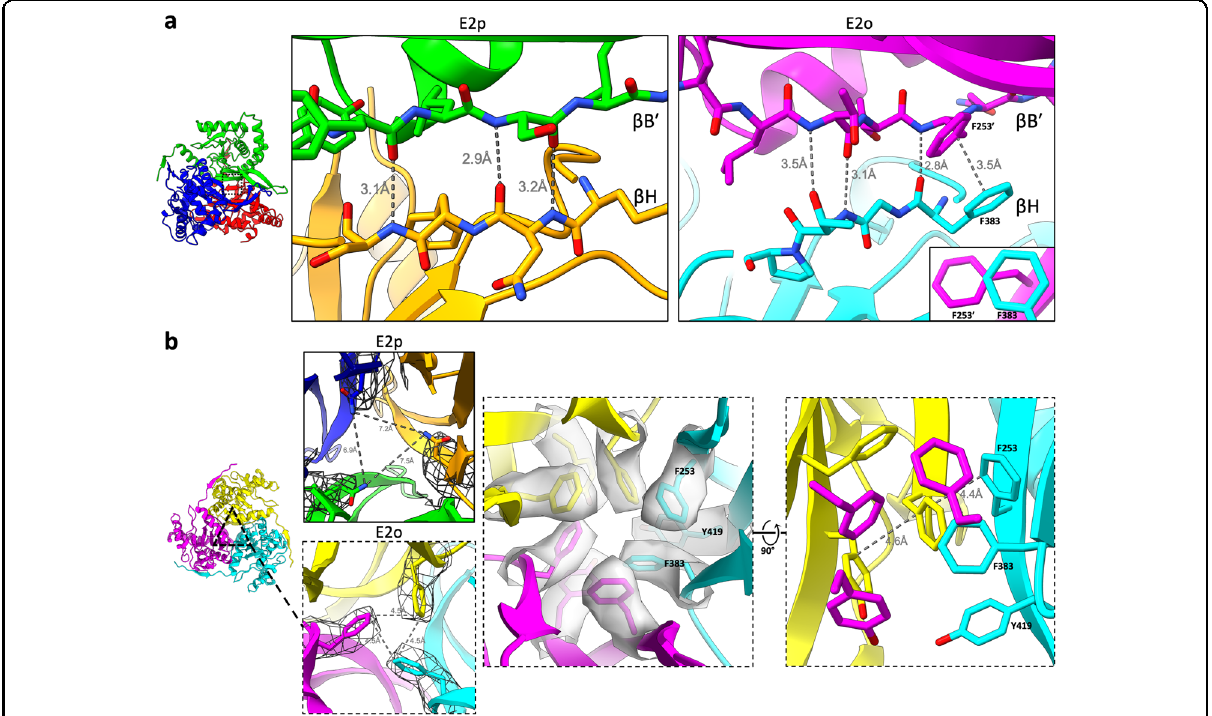
Fig. 4 π -stacking interdomain interaction network at the threefold interface. a View of the β H – β B ′ interface within the interdomain trimer for E2p (left) and E2o (right). β H (orange; cyan) forms three hydrogen bonds with β B ′ (green; magenta) in both E2p and E2o. The E2o interface has an additional slipped-parallel π -stacking interaction between Phe383 and Phe253 ′ . Inset shows offset rings from view along the parallel axes. b π - stacking interactions present at the threefold axis of E2o trimer but absent in E2p trimer. Expanded views along the threefold axis of E2o show an extended π -electron network formed by F253, F383, and